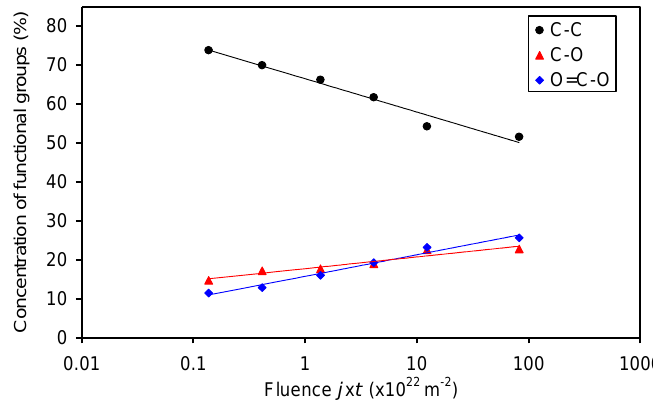
Figure 7. Variation of the concentration of various oxygen functional groups versus oxygen fluence. Concentrations were determined by fitting C 1s XPS spectra.